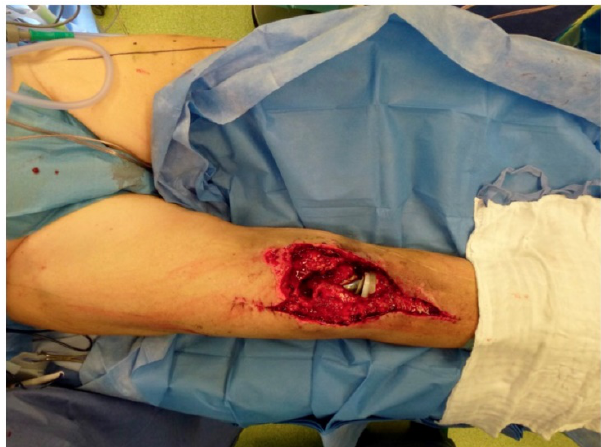
Figure 3: Partial defect of the extensor apparatus (EA): Right knee of a patient with PJI after TKA and a debridement, antibiotics and implant retention procedure, and a two-stage procedure performed twice. The combination of a medial and lateral incision pattern led to a large postoperative soft-tissue necrosis with a concomitant 50% patellar tendon and 40% quadriceps tendon lesion (Table 1: Patient No. 1; additional Figures 10, 11).